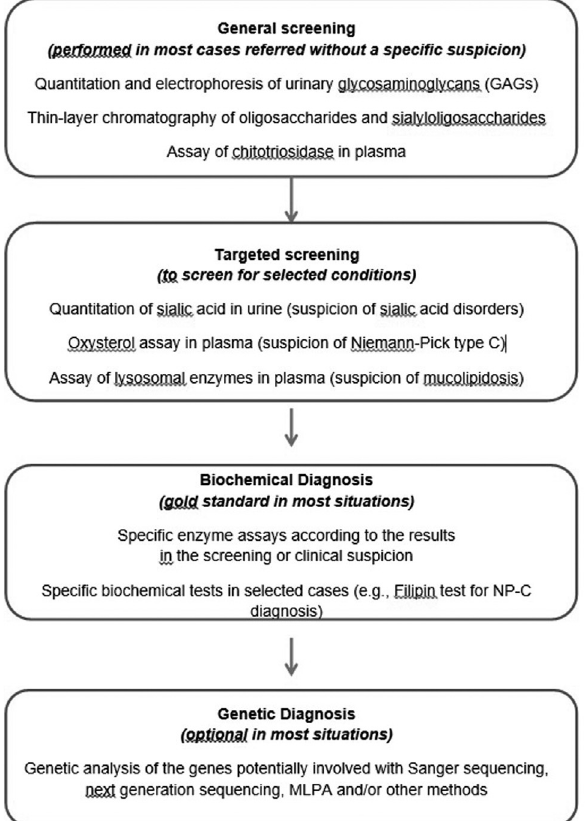
Figure 1 - Flowchart of the investigation for